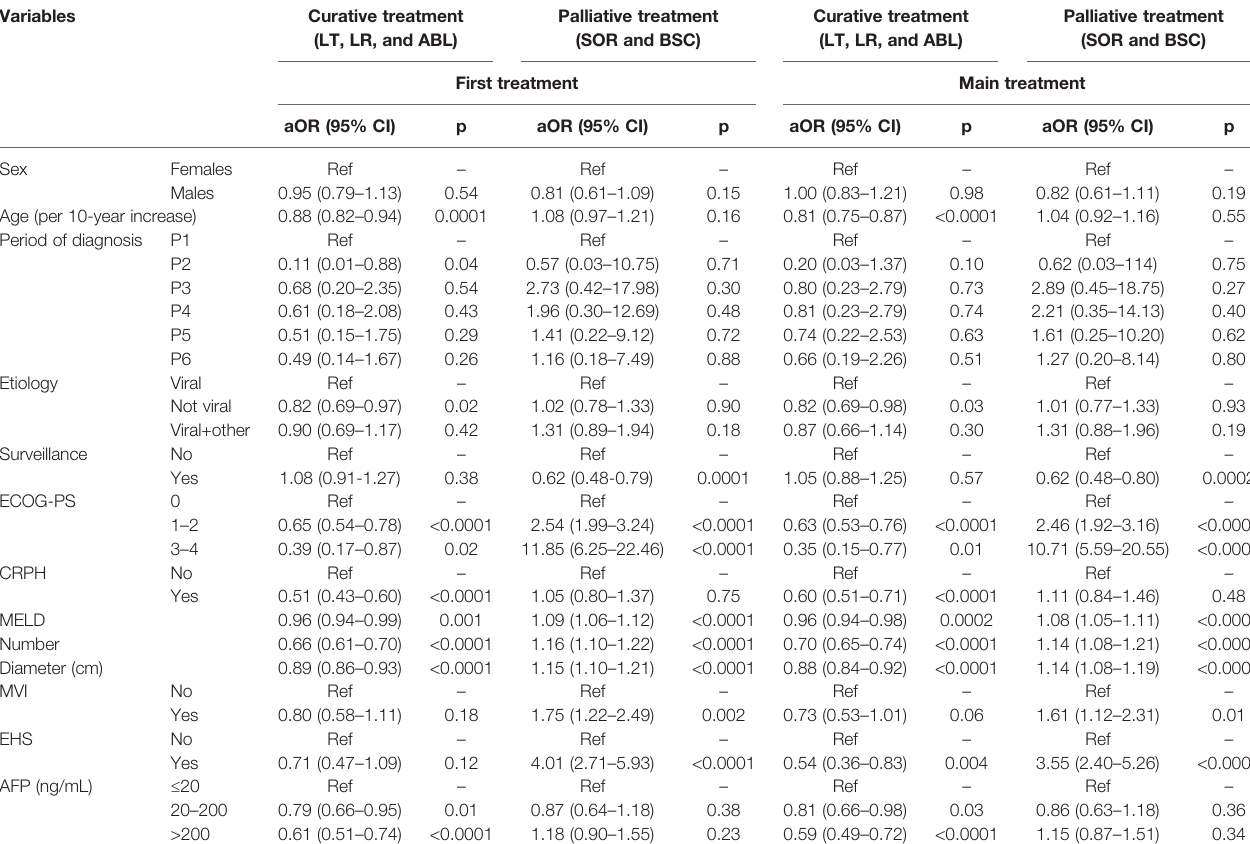
TABLE 3 | Multinomial logistic regression showing independent factors associated with probability of receive TACE compared to potentially curative treatment (LT, LR, and ABL) and palliative therapies (SOR and BSC).